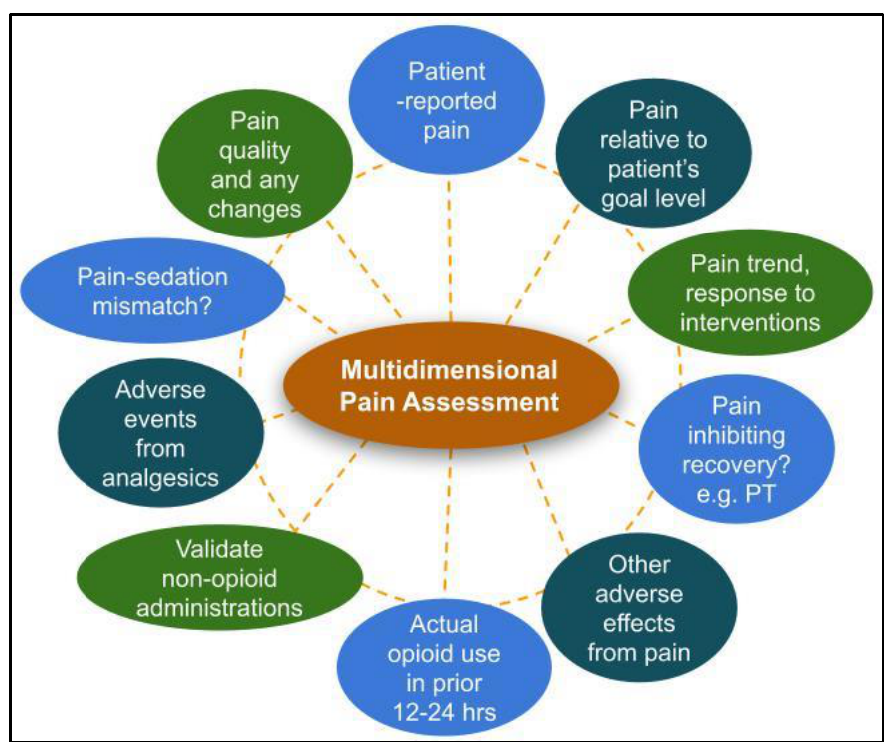
Figure 4. Recommended components of an effective multidimensional pain assessment. Legend: PT = physical therapy. Table 3. Estimated opioid pharmacokinetic parameters pertinent to pain regimen monitoring and